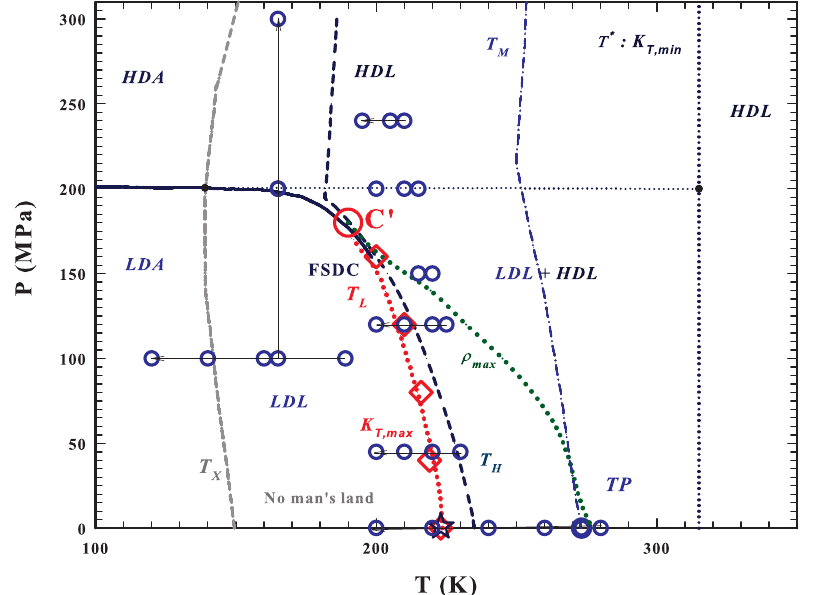
Figure 1. The T – P water phase diagram [49,54,56]. The metastable supercooled water is located between the homogeneous nucleation T H (dark blue dashed) and the melting T M (blue dotted-dashed) temperature lines. At ambient pressure, below its glass transition T g ≈ 130 K water is amorphous and on heating crystallizes at T X ≈ 150 K (dark gray dashed line). The region between T X and T H is the “No-Man’s Land”, where liquid bulk water cannot be studied experimentally. T L (dotted red line) represents the fragile to strong dynamical crossover FSDC line coincident with the Widom line and with the isothermal compressibility, κ T , maxima ( κ T , max ). This latter line ends at the water’s hypothesized second critical point C (cid:48) , reported as a large red circle. The FSDC temperatures ( T L ), measured at different pressures using the neutron scattering technique [33], are indicated as red diamonds; these data suggest that C (cid:48) is located at T C (cid:48) (cid:39) 200 K and P C (cid:48) (cid:39) 160 MPa. The line of the density maxima, ρ max , ending at about 180 MPa (green dotted line) and that of the κ T minima (blue dotted line), are also reported. The main areas of water polymorphism are indicated as LDA, HDA, LDL, HDL and that of the mixture as LDL+HDL (the only region where liquid water is a fragile former) [59,63]. The large blue circles represent the points of the measured inelastic neutron spectra (INS)